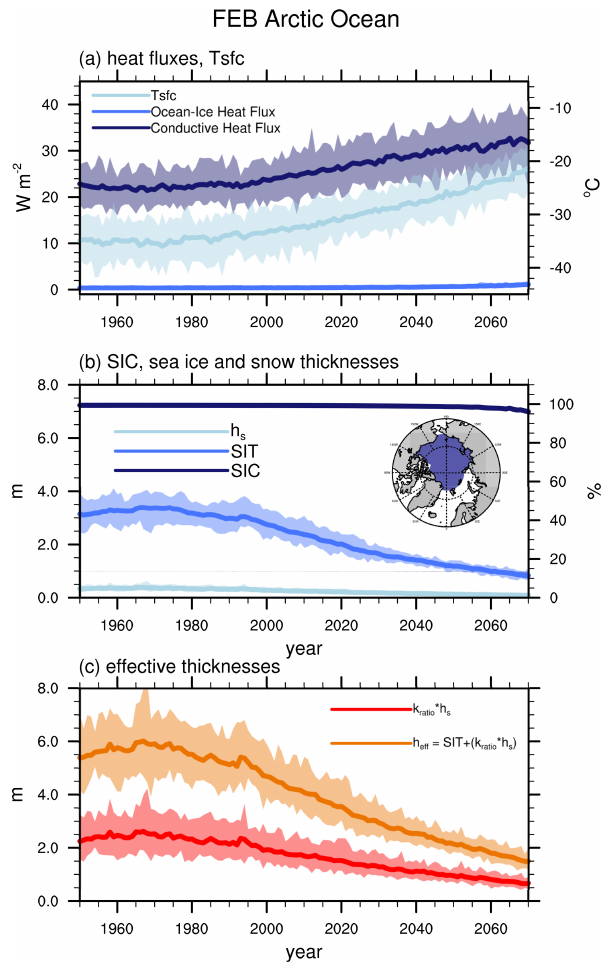
Figure 2. CESM1-LE February area-averaged Arctic Ocean (a) sur- face temperatures, turbulent ocean–sea ice heat fluxes, and conduc- tive heat fluxes (Tsfc); (b) SIC, SIT, and snow thicknesses ( h s ); and (c) effective snow thickness ( K ratio · h s ) and effective total thick- nesses ( h eff ). Ensemble means are shown as solid lines; ensemble ranges are opaque polygons. Arctic Ocean region is shown in the map insert in the middle